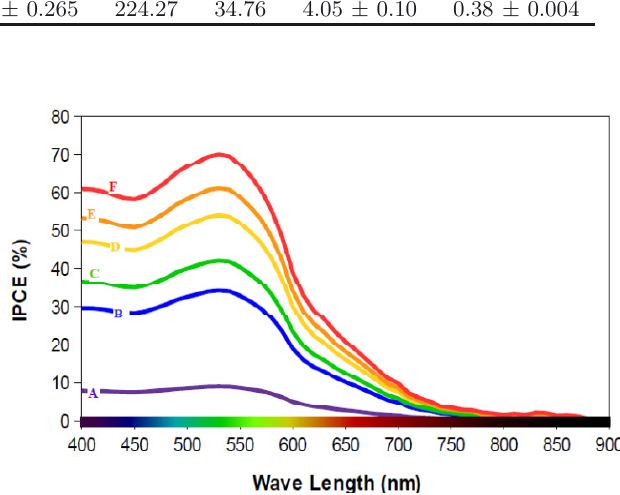
Fig. 7. Incident photon to current efficiency of the devices under A.M1.5, 100 W